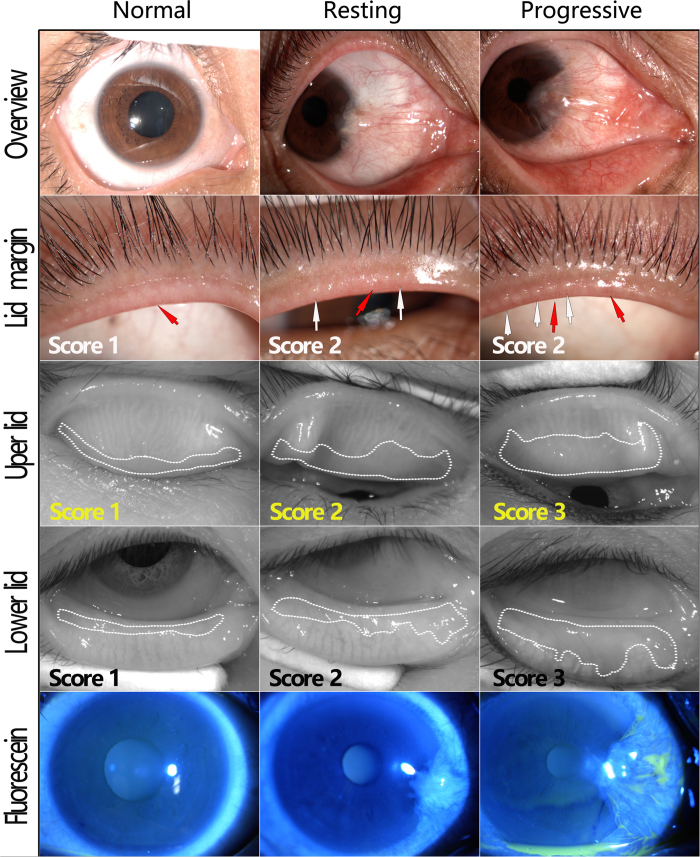
Representative images of lid margin, meiboghraphy of eye lids and fluorescein staining (Fluorescein) in patients from resting or progressive pterygium groups and normal controls.For lid margin and meibography of the eye lids, the score of each image is noted at bottom left. The left column shows normal eyes: the right eye from a 55-year-old female, OSDI: 13; NIBUT: 10.36 s; Schirmer test: 14 mm; the expressibility score was 2, and the meibum score was 1. The middle column shows eyes from resting pterygium group: the right eye from a 54-year-old female, OSDI: 19; NIBUT: 6.48 s; Schirmer test: 13 mm; the expressibility score was 2, and the meibum score was 2. The right column shows eyes from progressive pterygium group: the right eye from a 56-year-old female, OSDI: 26; NIBUT: 4.12 s; Schirmer test: 11 mm; the expressibility score was 3, and the meibum score was 3. The vascular engorgement is outlined by red arrow and plugged meibomian gland orifice is outlined by white arrow. The area of meibomian gland dropout was encircled with dotted white lines. Very few punctate corneal fluorescein staining in noted in pterygium eyes.